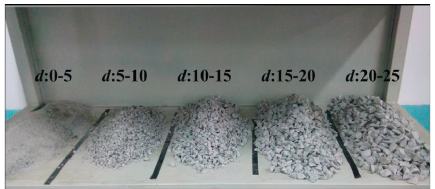
Figure 1: Fractured sandstone samples of different particle